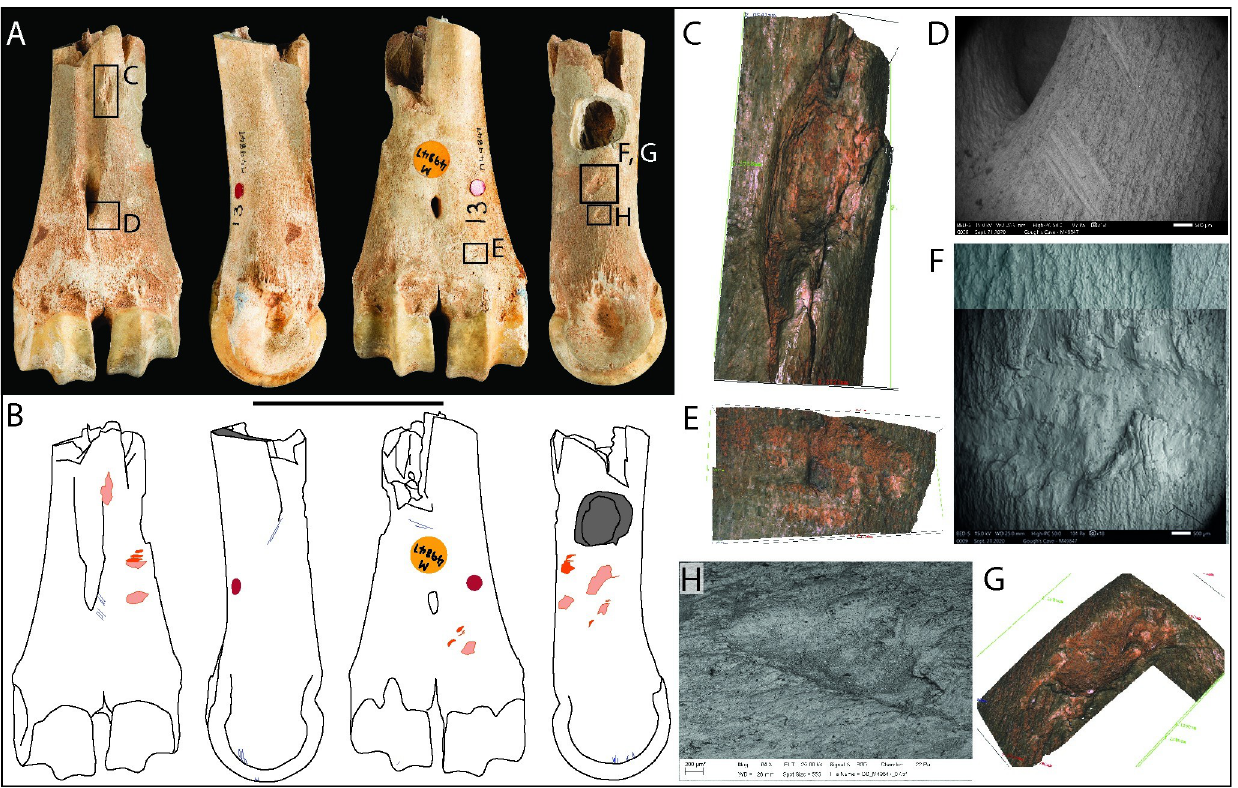
Fig 9. Photographs ( A ) and drawings ( B ) of red deer distal metatarsal M49847, showing knapping marks (pink), cut marks (blue) and samples (drilled hole = dark grey, cut piece = red oval) in dorsal, medial, plantar, and lateral views (Scale = 50 mm). SEM micrographs and Alicona images detail a point of impact with associated flaking ( C ), superficial slicing cut marks made with the tool held at an oblique angle to the bone surface ( D ), and knapping marks on the plantar and lateral faces ( E-G ).